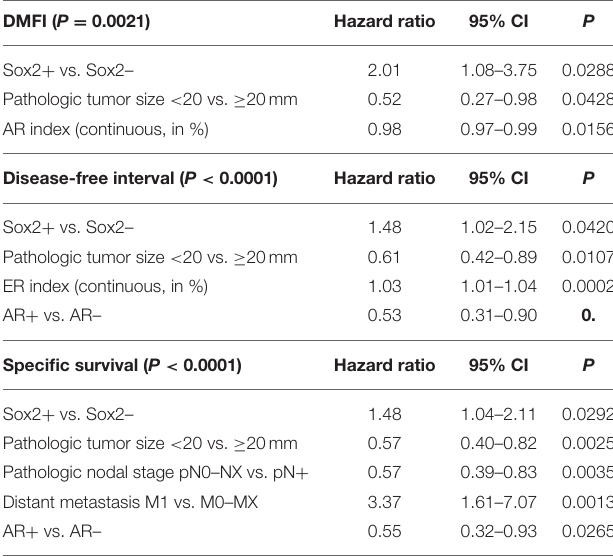
TABLE 3 | Unfavorable prognostic value of Sox2 (at > 42% cutoff) in feline mammary carcinomas (multivariate survival analyses, N = 180